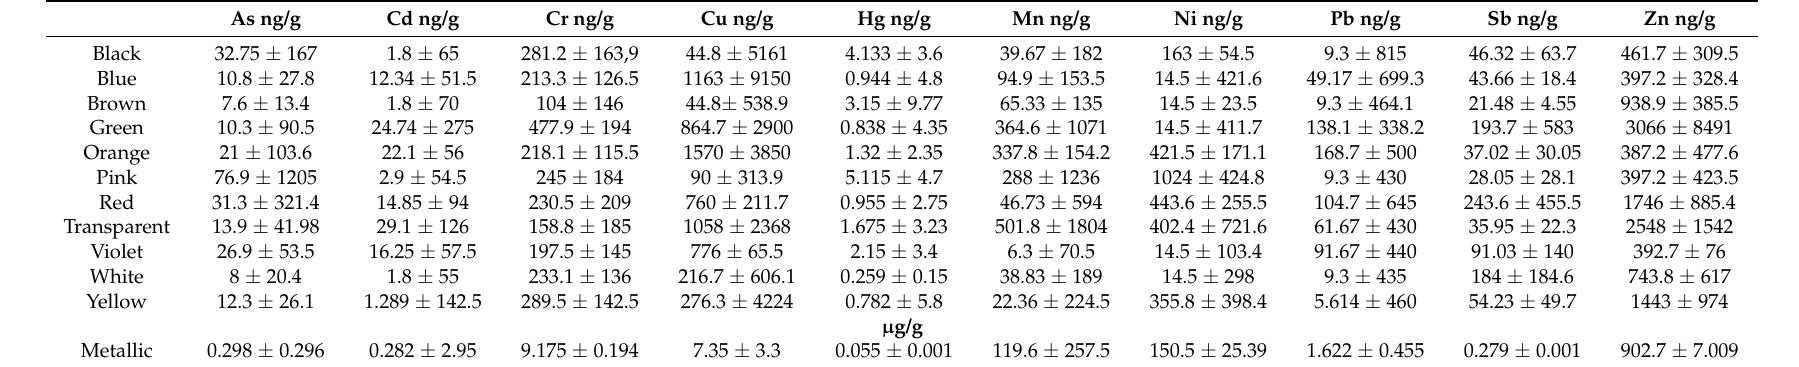
Table 2. Average concentration of metals and metalloids in various colors of toys in HCl